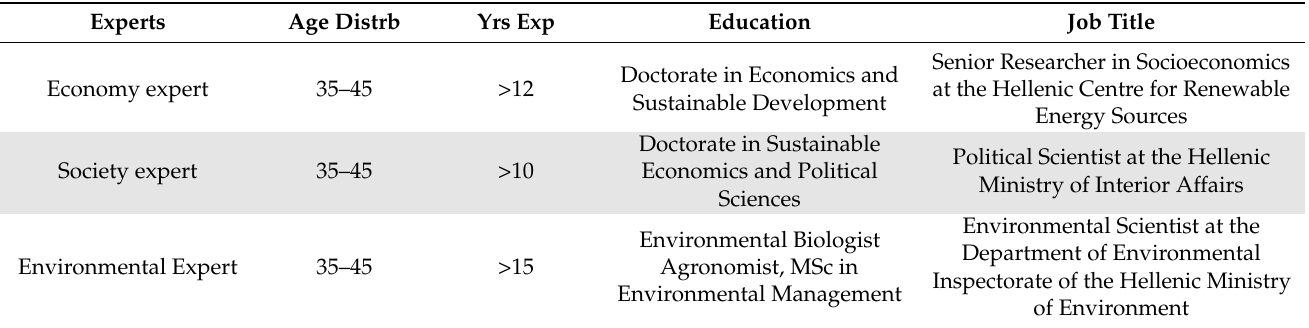
Table 4. Experts’